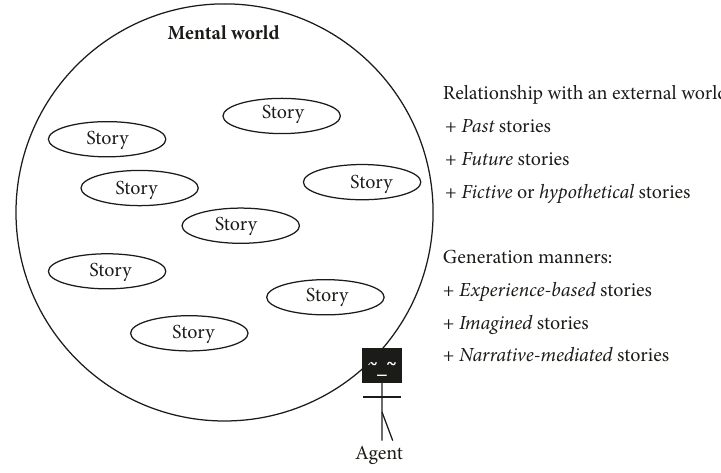
Figure 1: An agent’s mental world formed by